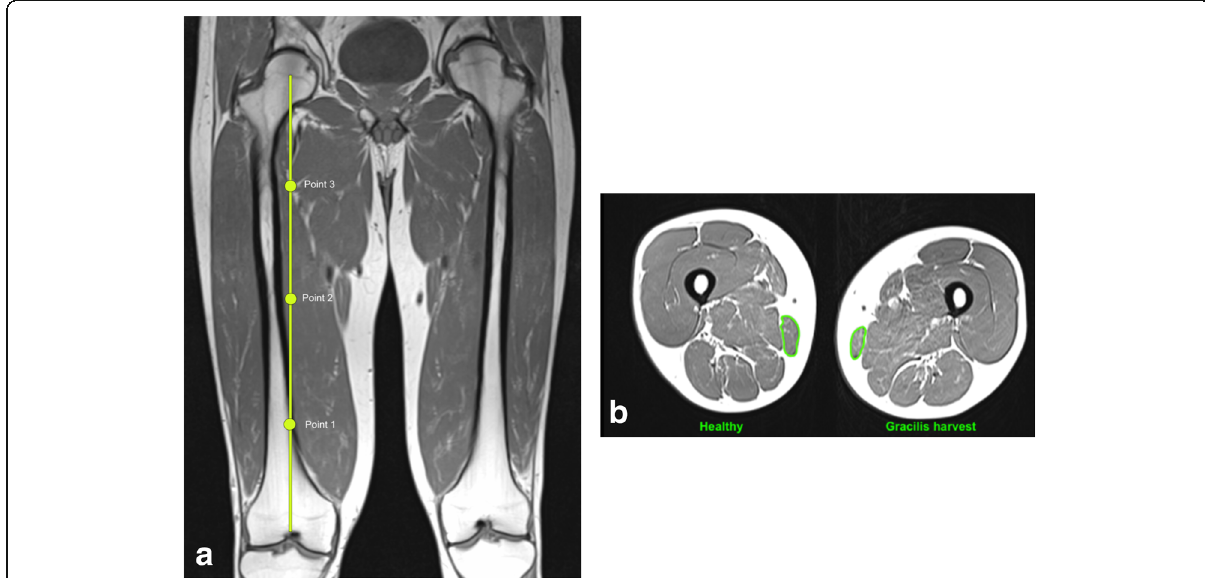
Fig. 1 a and b Measurement of the CSA of the gracilis muscle. The bullets indicate 25%, 50% and 75% of the length of the femur from distal. Gracilis harvest = limb with previous harvest of the gracilis tendon, Healthy = contralateral